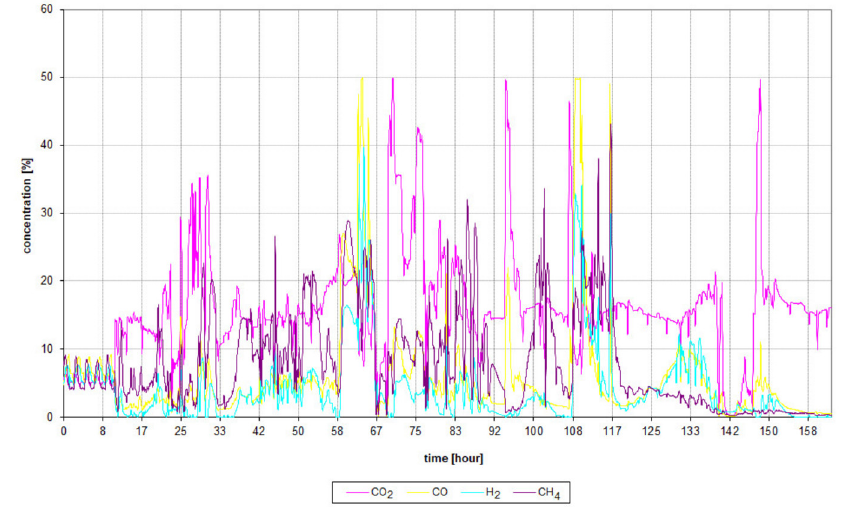
Figure 14. The syngas composition behavior during the first experiment.